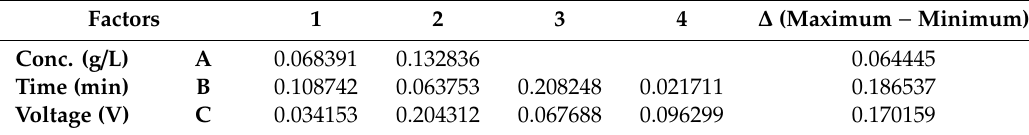
Table 6. Mean of the deposition yield’s standard deviation.